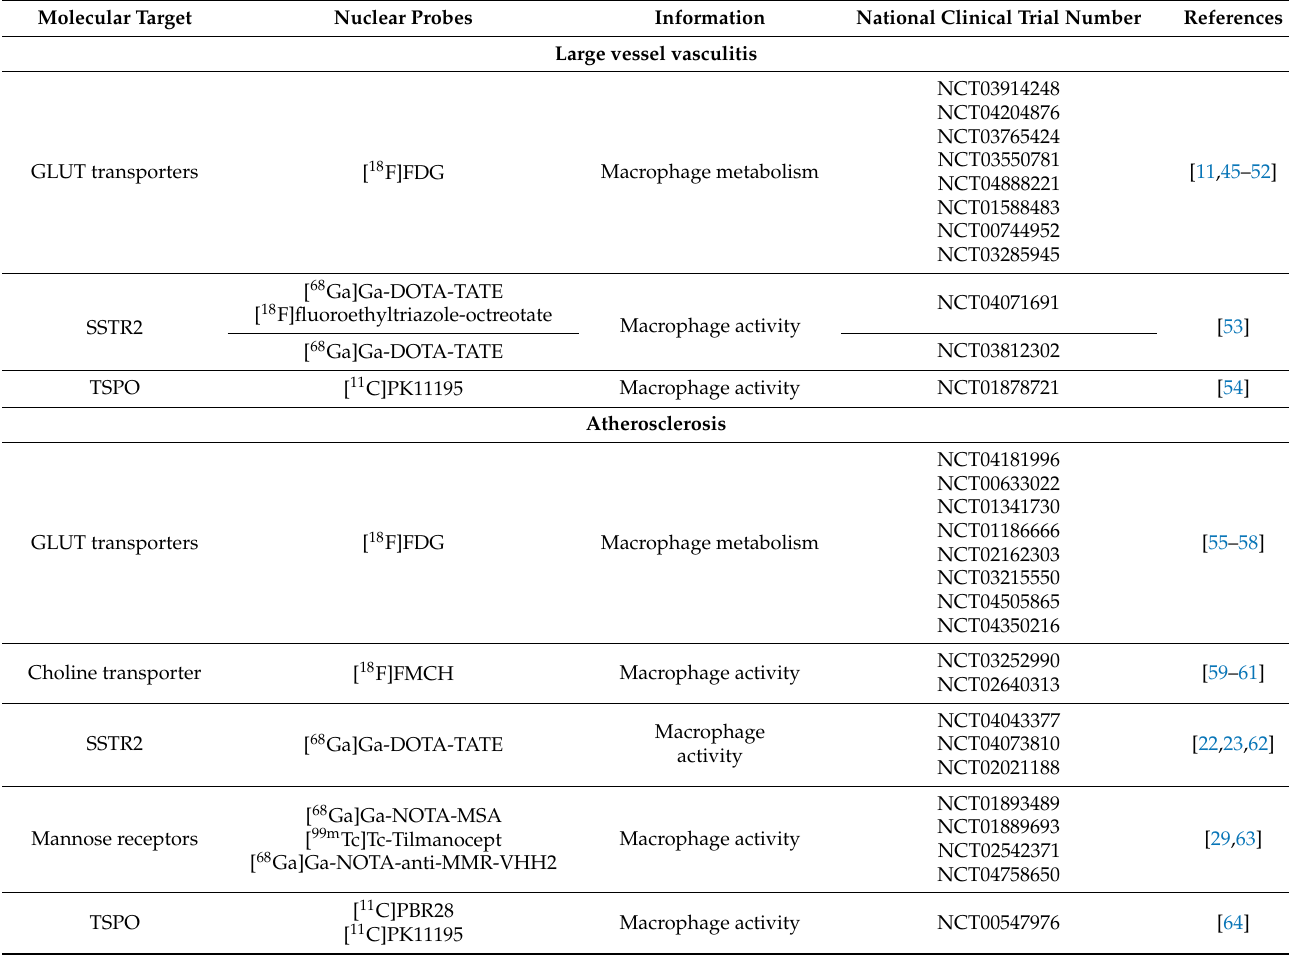
Table 1. Registered clinical trials evaluating nuclear probes to image vascular inflammation in large vessel vasculi- tis and atherosclerosis. [ 18 F]FDG: 2-[ 18 F]fluoro-2-deoxy- D -glucose; SSTR2: somatosatin receptor 2; 68 Ga: Gallium-68; 64 Cu: Copper-64; [ 18 F]FMCH: [ 18 F]fluoromethylcholine; [ 68 Ga]Ga-NOTA-MSA: [ 68 Ga]Ga-NOTA-neomannosylated hu- man serum albumin; anti-MMR-VHH2: nanobody targeting macrophage mannose receptor; [ 11 C]PBR28: [ 11 C] N -acetyl- N -(2-methoxybenzyl)-2-phenoxy-5-pyridinamine); [ 18 F]RGD-K5: 18 F-fluorination of an arginine-glycine-aspartic acid derivated peptide targeting integrin α v β 3; FAP: fibroblast activating protein; FAPI: fibroblast activating protein inhibitor; CCR2: C–C chemokine receptor 2; ECL1i: extracellular loop 1 inverso; A β : beta amyloid deposits. Molecular